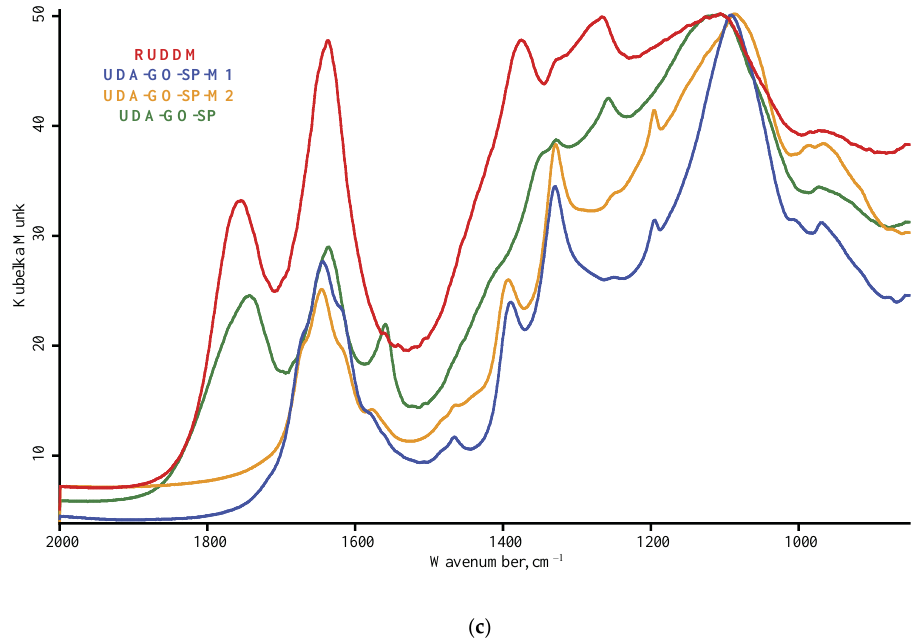
Figure A1. Diffuse reflectance mode, LN-MCT photovoltaic detector; nanodiamond brands: red, RUDDM; blue, UDA-GO-SP-M1; orange- UDA-GO-SP-M2; green, UDA-GO-SP; ( a ) 6000–4000 cm −1 , ( b ) 4000–2000 cm −1 ( c ) 2000–800 cm –1 range. Spectra were smoothed (13 points) and normalized to maximize each spectrum.